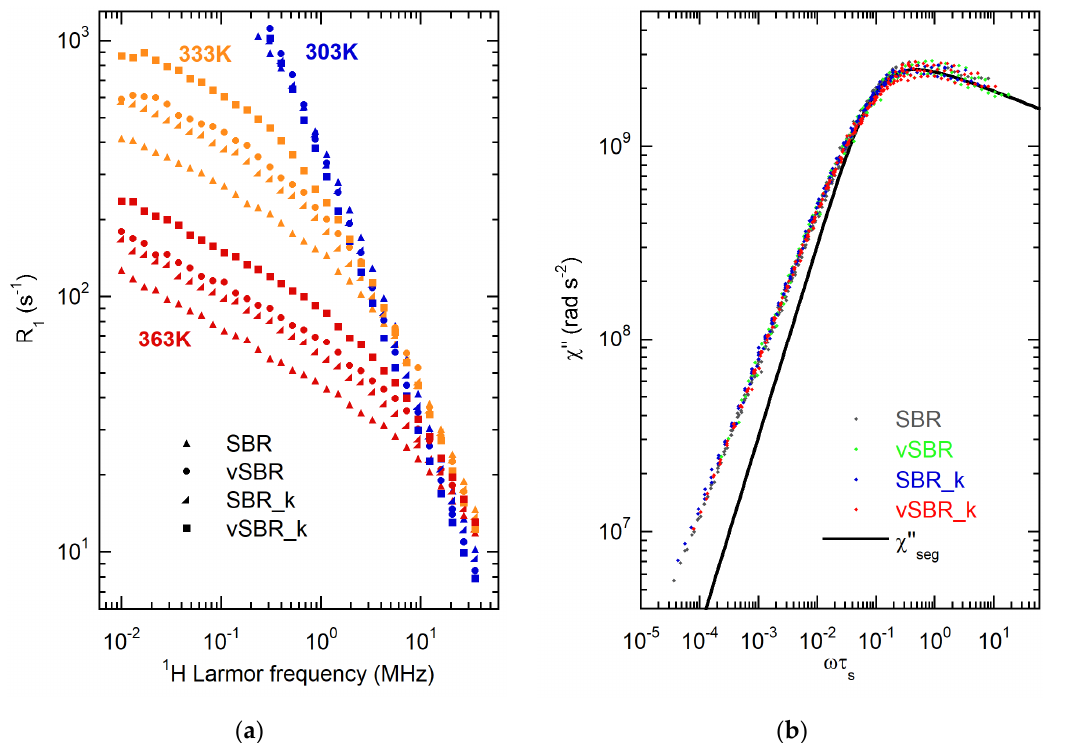
Figure 3. ( a ) 1 H NMRD curves for the investigated samples at the indicated temperatures. ( b ) Susceptibility master curves of the indicated samples; the black line represents the contribution of the segmental dynamics to the χ′′ ( ωτ s ) master curve of SBR_k. For all samples, at low temperatures, R 1 shows a power law dependence on Larmor ∼ = frequency with γ 1, suggesting that R 1 relaxation is dominated by segmental dynamics (Regime 0). Correspondingly, the χ ”( ω ) curves display a maximum associated with